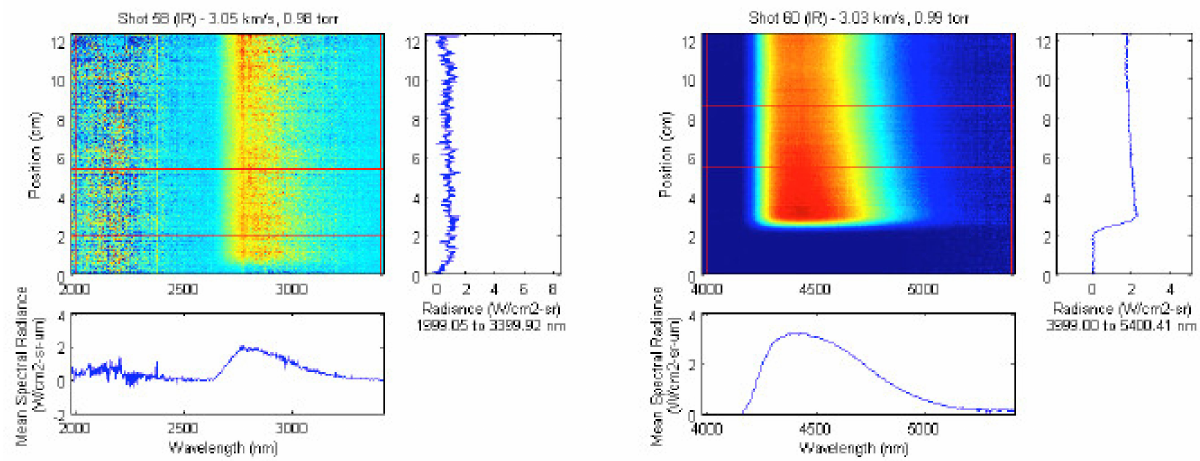
Figure 29. Spectral and spatial radiation measurements at 3 km/s and 1 Torr in pure CO 2 (left: 2700 nm band, right 4300 nm band) (from [29]).